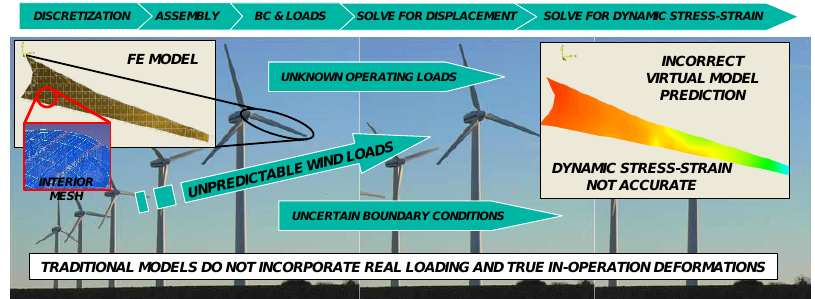
Fig. 1. Schematic showing normal finite element model development.